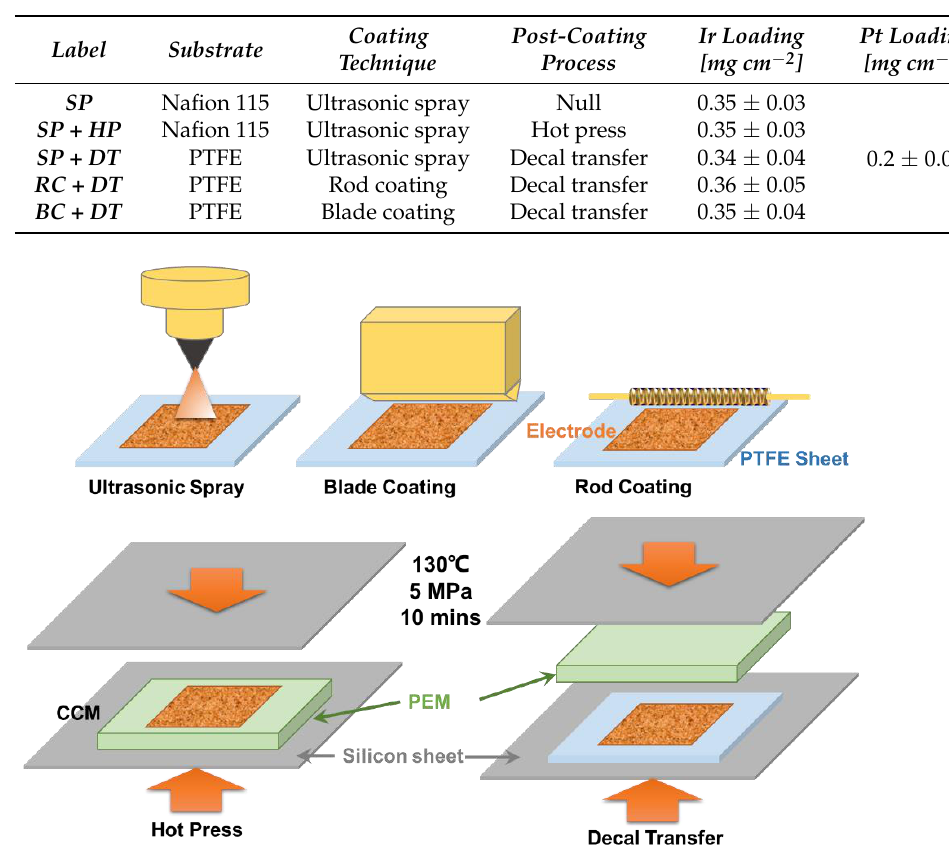
Table 1. Details of the various anode electrodes in this study.